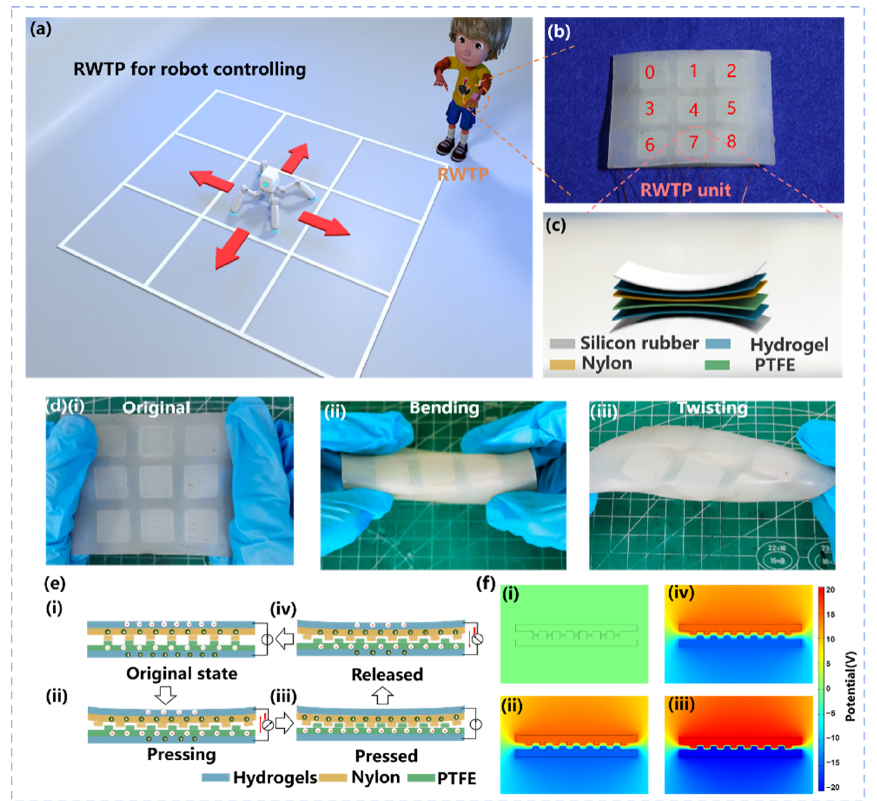
Figure 1. Structure design and working principle of RWTP: ( a ) schematic of real-time control of a robot; ( b ) image of an as-fabricated RWTP; ( c ) layer-by-layer structure of RWTP unit; ( d ) images of RWTP in its ( i ) original, ( ii ) bending, and ( iii ) twisting states; ( e ) working principle of RWTP; ( f ) potential simulations by COMSOL to elucidate the working principle ( i ) original state, ( ii ) pressing state ( iii ) pressed state and ( iv ) released